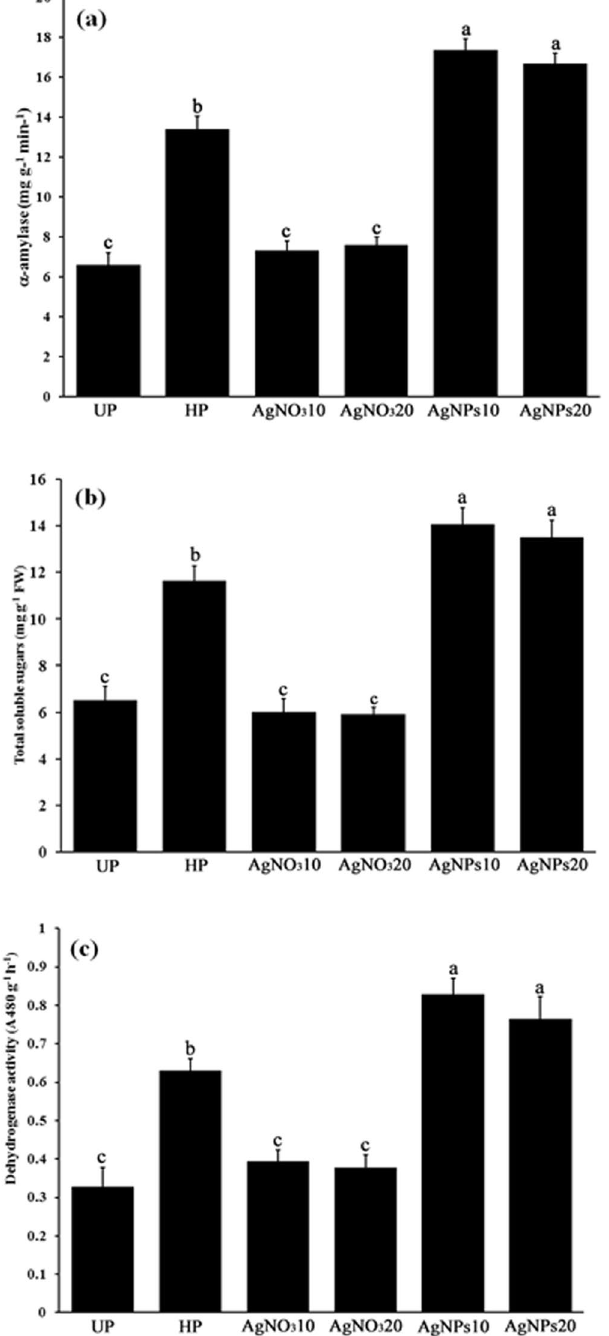
Figure 5. Impacts of different priming agents on starch metabolism and root dehydrogenase activity of rice seedlings, ( a ) α -amylase activity, ( b ) total soluble sugars, and ( c ) dehydrogenase activity. Data are presented as mean ± SE. Means denoted by the different letter are significantly different at p < 0.05 according to the Duncan’s multiple range